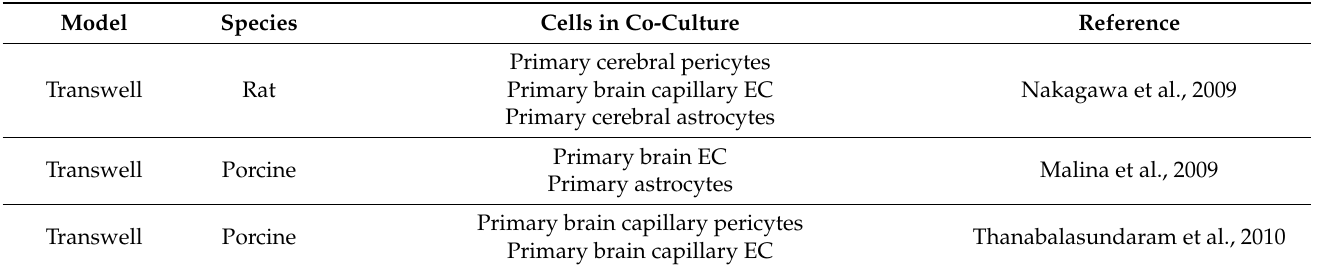
Table 1. Summary of in vitro BBB